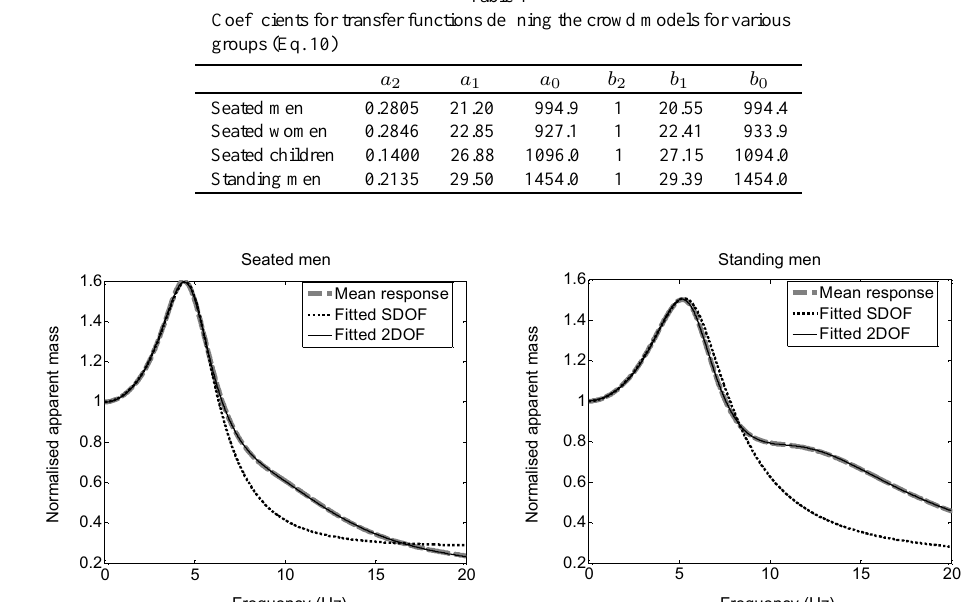
Fig. 8. Mean normalised apparent mass of seated (left) and standing (right) men plotted with fitted SDOF and 2DOF